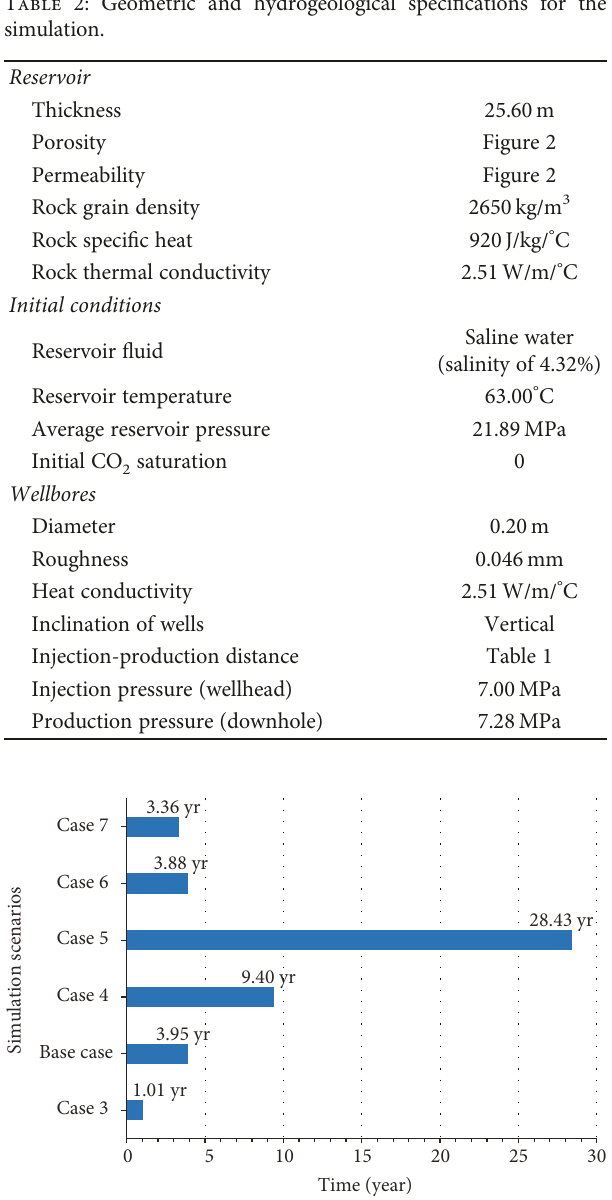
Figure 5: The shut-in time for di ff erent CO scenarios